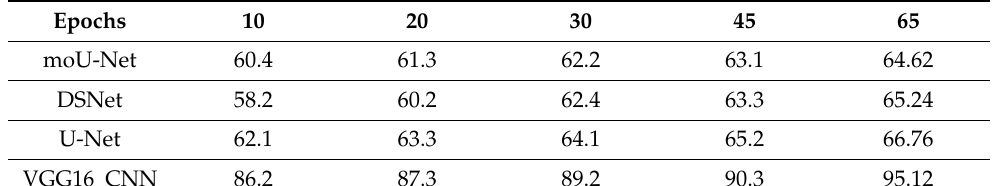
Table 5. Comparison of F1-score over various epochs between existing techniques and proposed methodology.